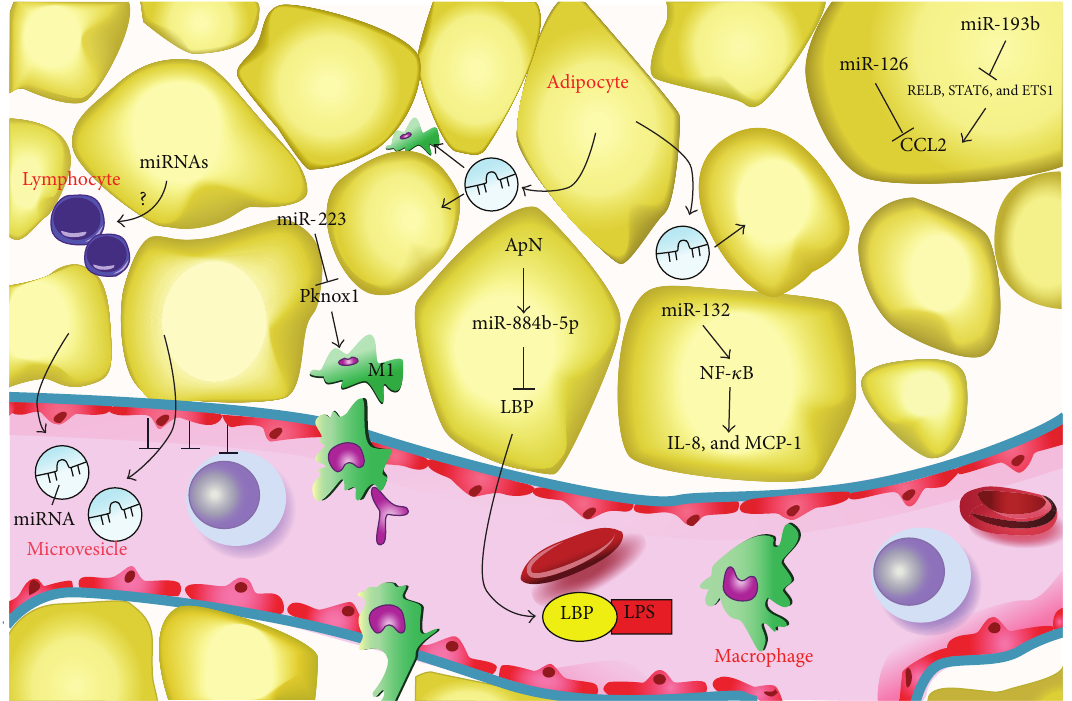
Figure 1: Scheme for the miRNA-mediated mechanisms in regulating white adipose tissue inflammation. The miR-132 activates NF- 𝜅 B and the transcription of downstream adipokines IL-8 and MCP-1. The miR-223 played a crucial role in modulating macrophage polarization, which suppresses the infiltration of proinflammatory M1 “classically activated” macrophages by targeting Pknox1. The miR883b-5p, which is upregulated by ApN represses the expression and secretion of LBP, a LPS facilitator. The miR-126 reduces the production of CCL2 by targeting directly the 3 󸀠 -UTR of CCL2, while miR-193b inhibited indirectly the CCL2 production through downregulating the transcription factors of CCL2 (RELB, STAT6, and ETS1). The microvesicles released by adipocytes may either go into circulation or transfer into the neighboring adipocytes or macrophages, probably acting as inflammatory communicators between adipocytes, macrophages, and distant cells. The arrows indicate stimulation or activation; blunted arrows indicate inhibition. ApN, adiponectin; LBP, LPS-binding protein; LPS, lipopolysaccharide; CCL2, chemokine (C-C motif) ligand 2, adapted from